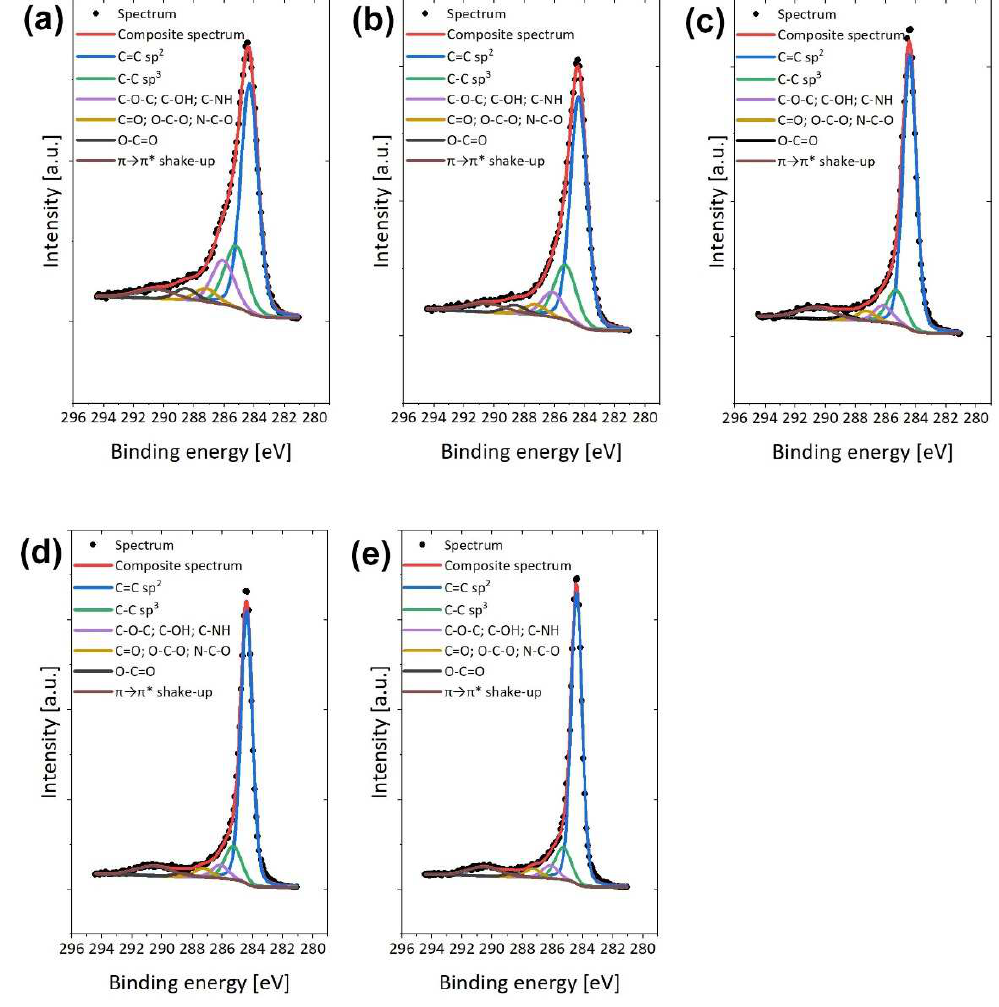
Figure 5. XPS spectra of carbon nanofibers carbonized at different temperatures. Deconvoluted C1s peaks at ( a ) eCNF750, ( b ) eCNF1000, ( c ) eCNF1500, ( d ) eCNF1750 and ( e ) eCNF2000.